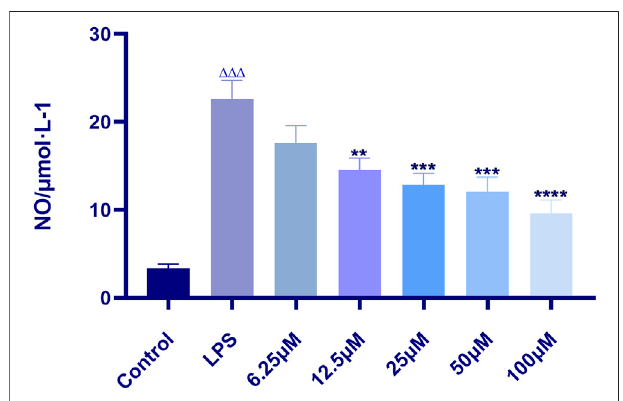
FIGURE 3 | Effect of indomethacin on NO production in RAW 264.7 inducedbyLPS.Dataarepresentedasmeans ± SD, n (cid:2) 5.**means p < 0.01, *** means p < 0.001, **** means p < 0.0001 compared with LPS group. △△△ means p < 0.001 compared with control